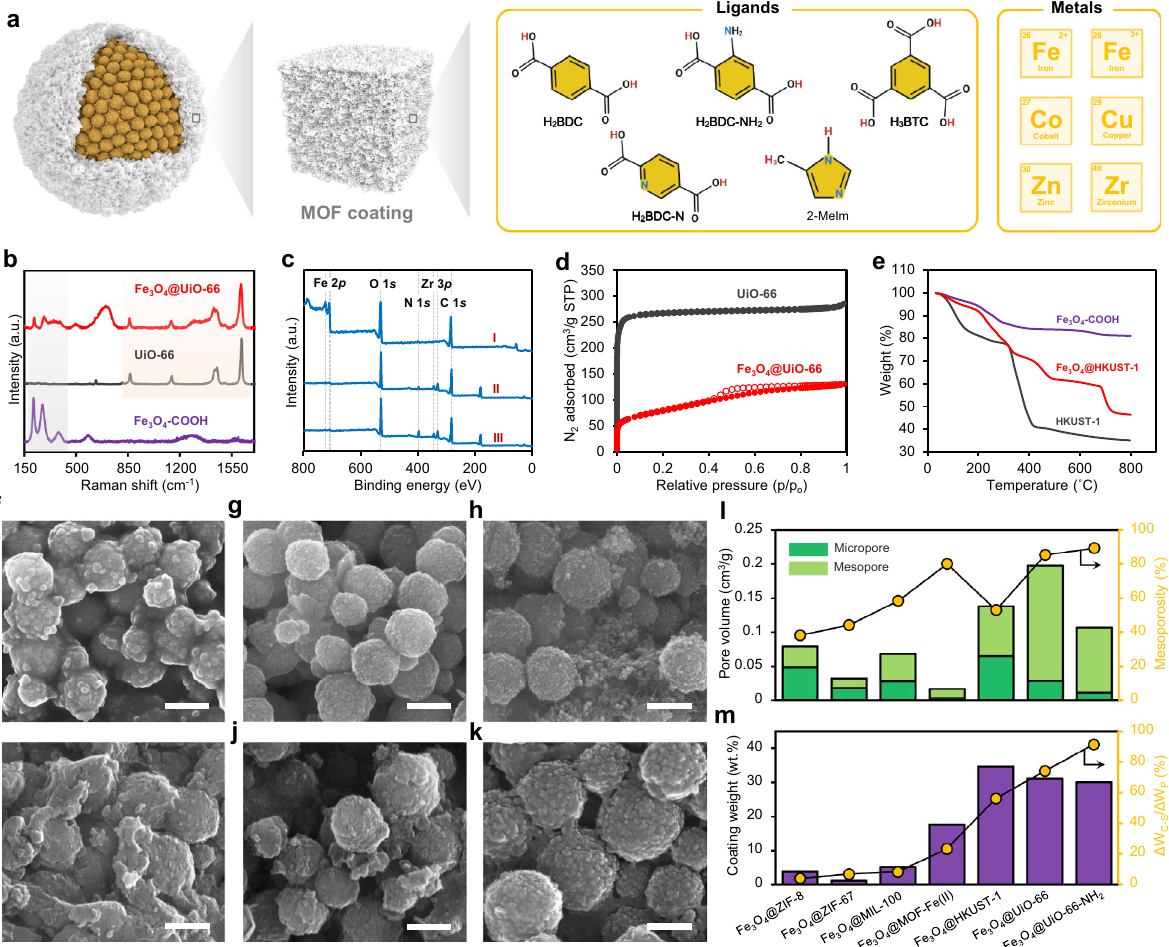
Fig. 3 Structural tailoribility of MOFs via modulated self-assembly. a Schematic diagram of different metal ions and organic ligands used to grow various MOF coatings with unique physicochemical characteristics. b Raman spectra of the Fe 3 O 4 – COOH, UiO-66, and Fe 3 O 4 @UiO-66. c Full survey XPS spectra of Fe 3 O 4 @HKUST-1 (I), Fe 3 O 4 @UiO-66 (II), and Fe 3 O 4 @UiO-66-NH 2 (III). d Nitrogen adsorption-desorption isotherms of UiO-66 and Fe 3 O 4 @UiO-66 at 77 K. e TGA pro fi les of the Fe 3 O 4 -COOH, HKUST-1, and Fe 3 O 4 @HKUST-1 under nitrogen atmosphere. SEM images of f Fe 3 O 4 @ZIF-8, g Fe 3 O 4